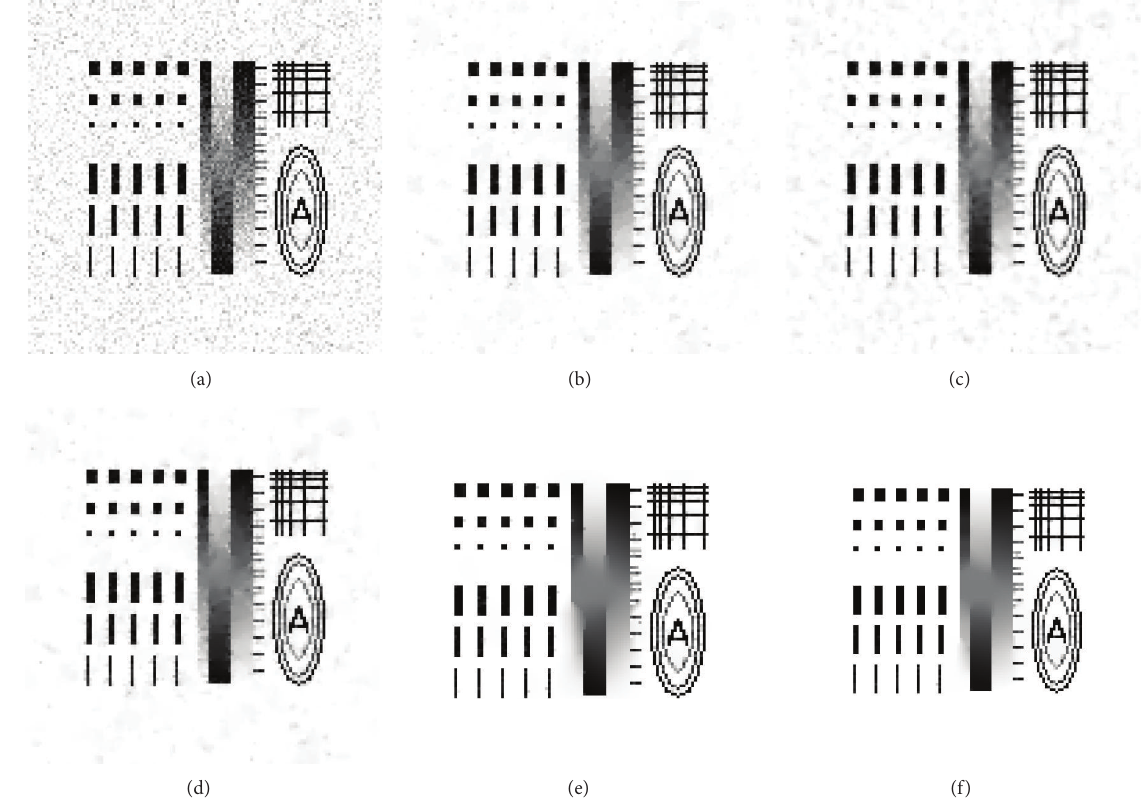
Figure 3: Results of different models for the synthetic image 1: (a) the noisy image, the restored images by (b) the ROF model, (c) the LLT model, (d) the hybrid model, (e) our Model 1 ( 𝛼 = 0.1 and 𝑟 = 1 ), and (f) our Model 2 ( 𝛼 = 0.18 and 𝑟 = 1 ).